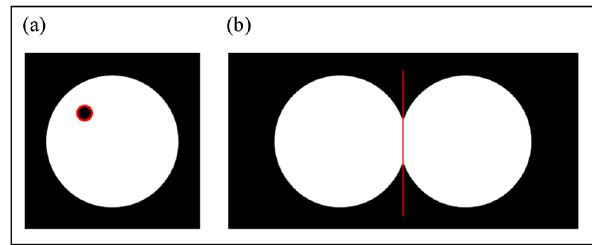
Figure 5: Schematic diagram of image processing. ( a ) Removing holes and ( b ) splitting